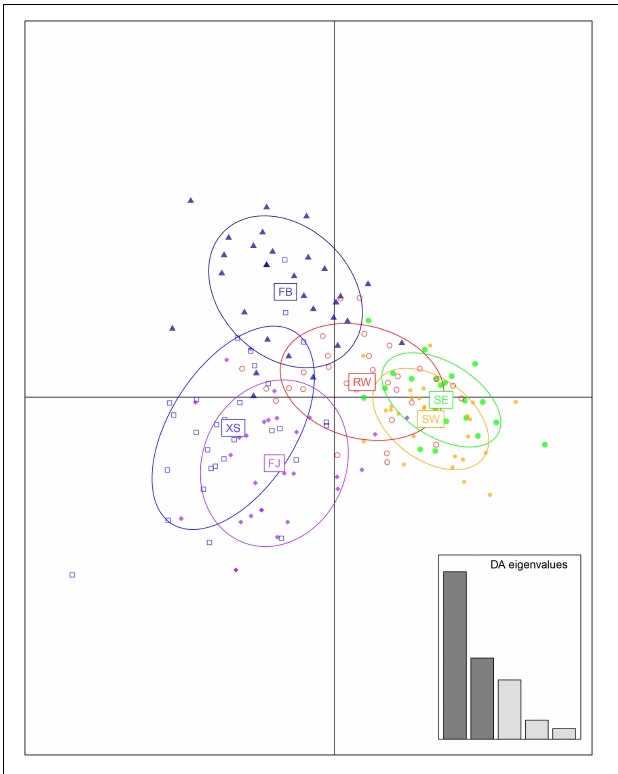
FIGURE 5 | Discriminant analysis of principal components for farmed and spontaneous populations of Saccharina japonica from a kelp farm in China.